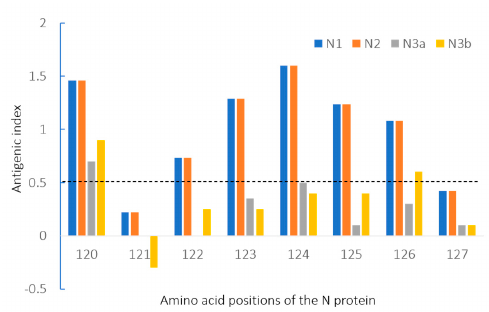
Figure 5. Antigenic index analysis of N gene sequences in PEDV strains. Genogroup N3 exhibited lower antigenic indexes, below 0.5 (cut-off value), compared with genogroups N1 and N2. This region is in a B-cell epitope sequence of the N protein, which is one of the PEDV -specific epitopes (amino acids 18–133 and 252–262).